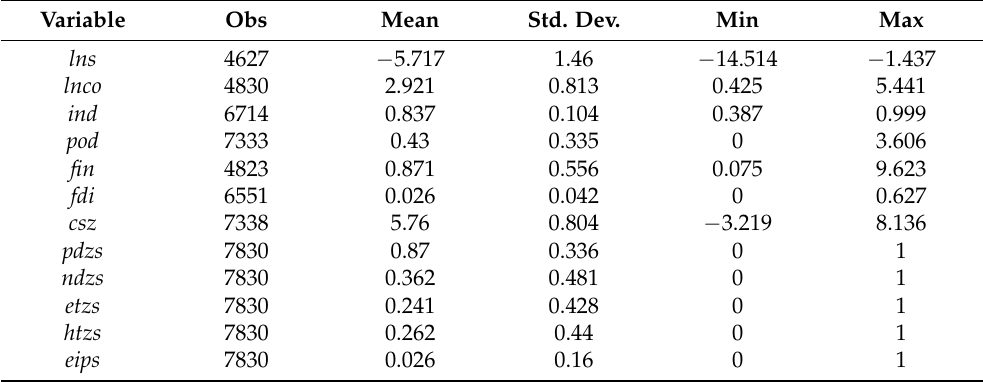
Table 1. Descriptive statistics of each